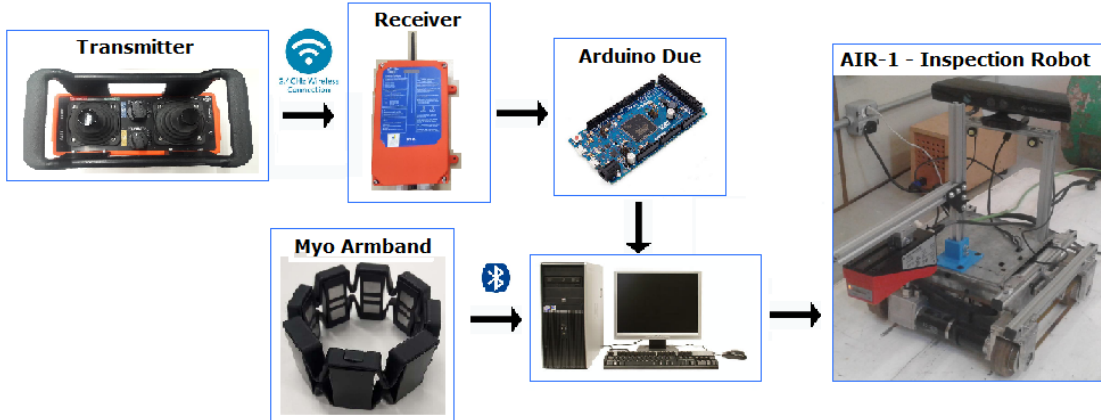
Figure 4. System architecture. An industrial joystick is operated by sending signals via radio frequency to a receiver. The data are processed in the Arduino DUE and sent to the computer that controls the robot. The operator also wears a Myo armband to assist with the robotic